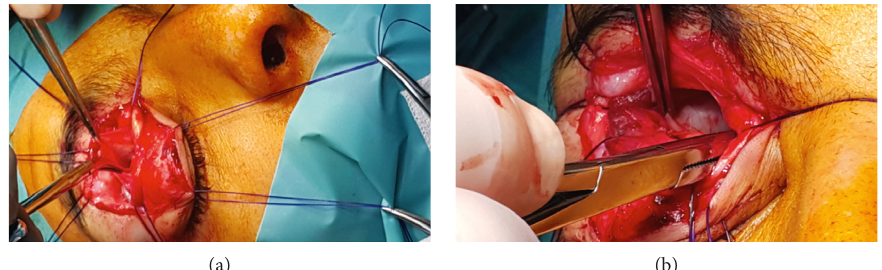
Figure 4: Intraoperative images. (a) We raise the split Tenon-case with clips. The ocular muscles are elevated by several suture threads. (b) Retrobulbar area filled with the bluish-gray color, encapsulated